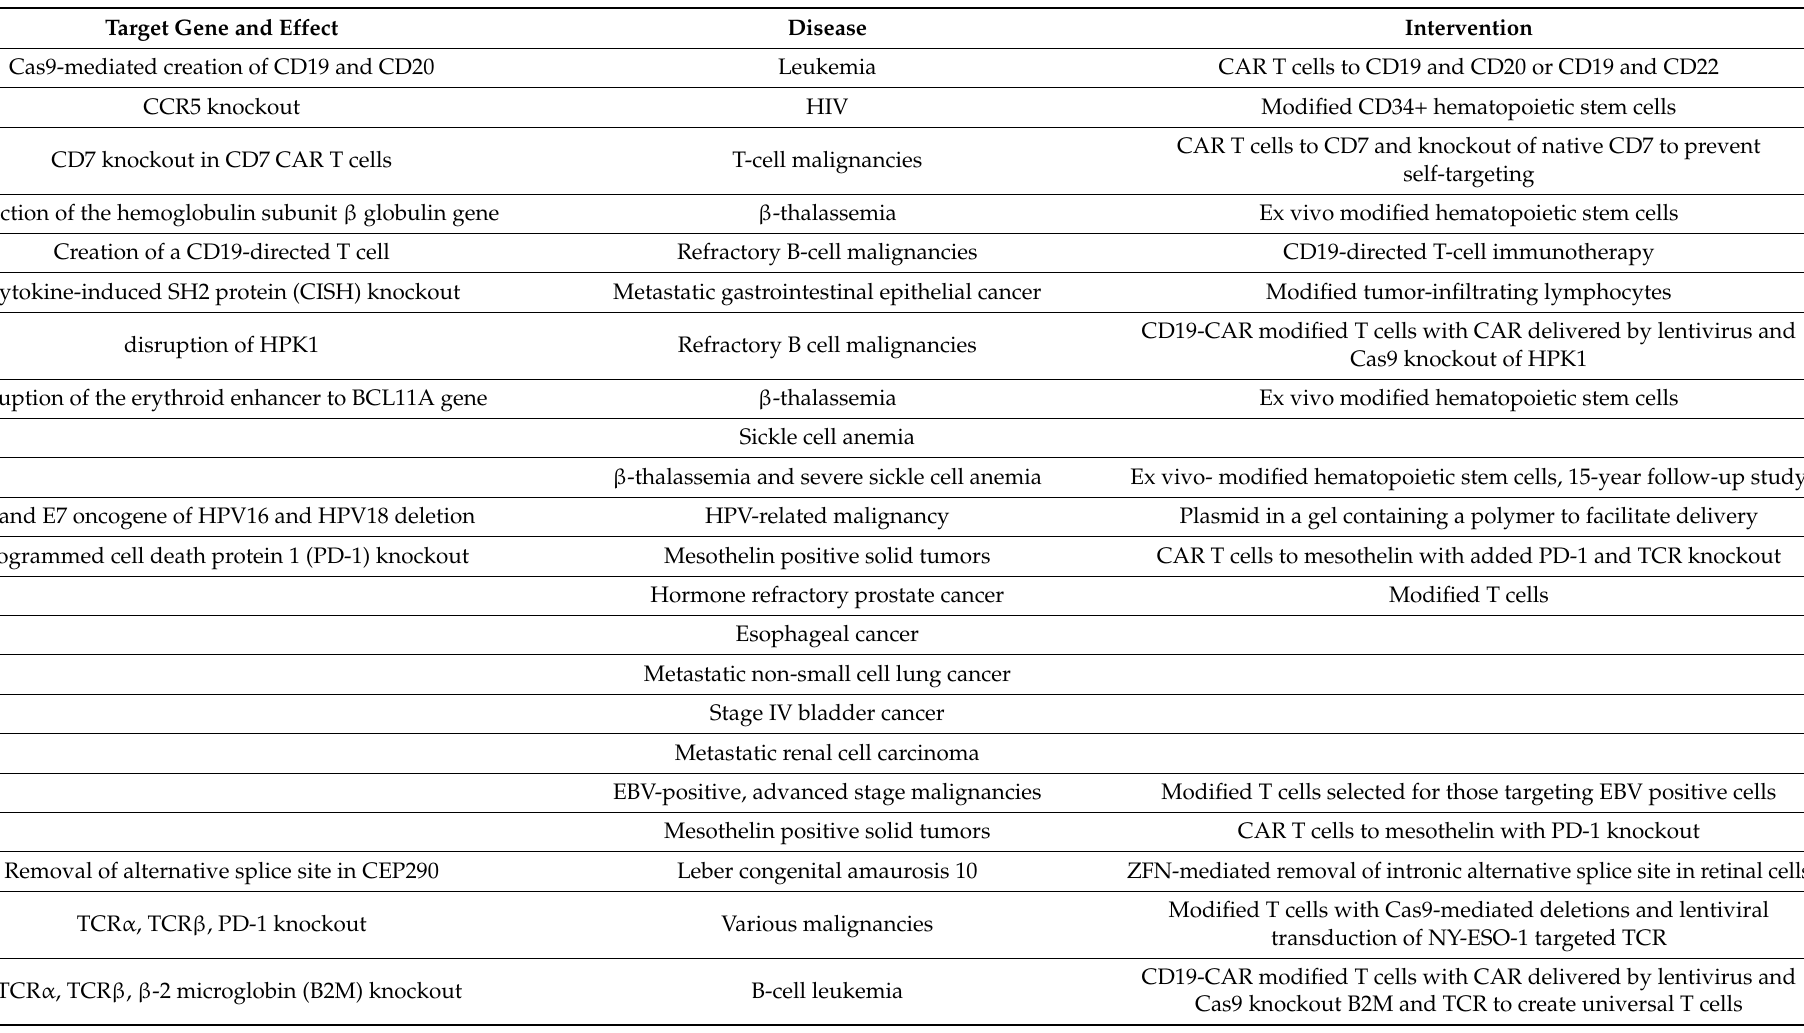
Table 4. Several examples for clinical trials with genome editor of